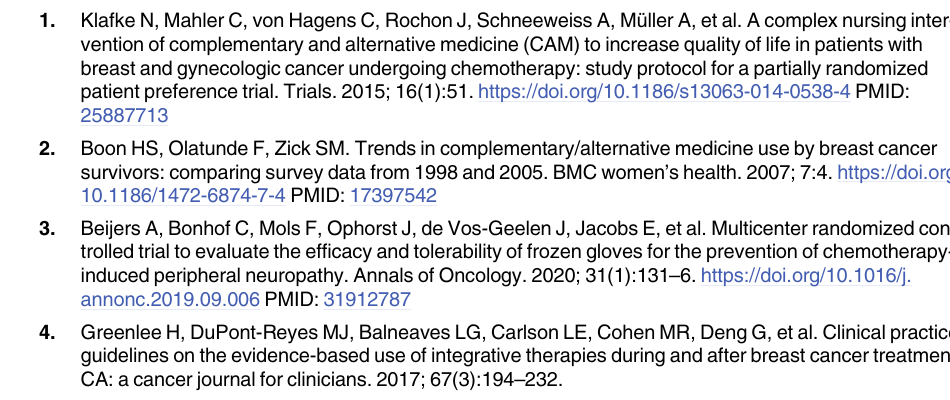
S1 Fig. Spirit figure 2013. S2 Fig. Times of data collection and